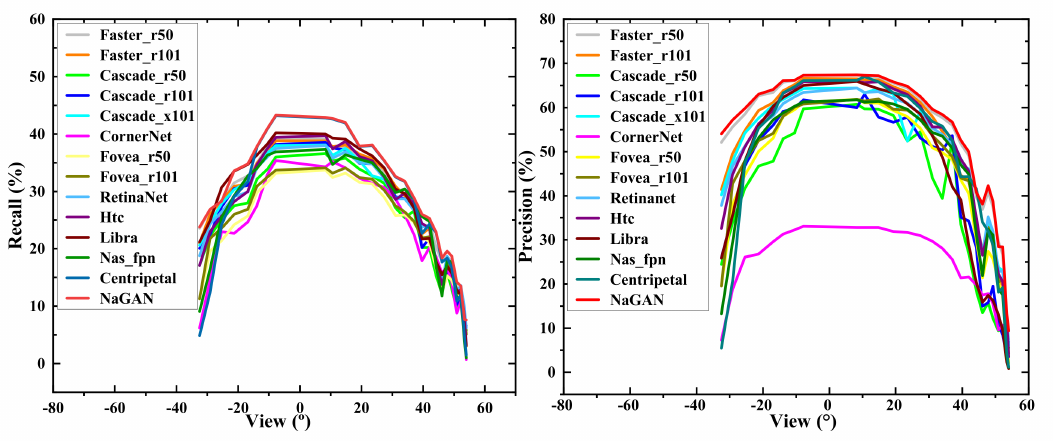
Figure 5. Performance of AR@0.5:0.95 and AP@0.5 of different methods for various views. Many prevailing models and NaGAN trained on ALL were assessed for the building detection task, and the AR@0.5:0.95 and AP@0.5 results are shown for each evaluated view. Imagery facing south is symbolized with a negative number, whereas views facing North are presented with a positive value.